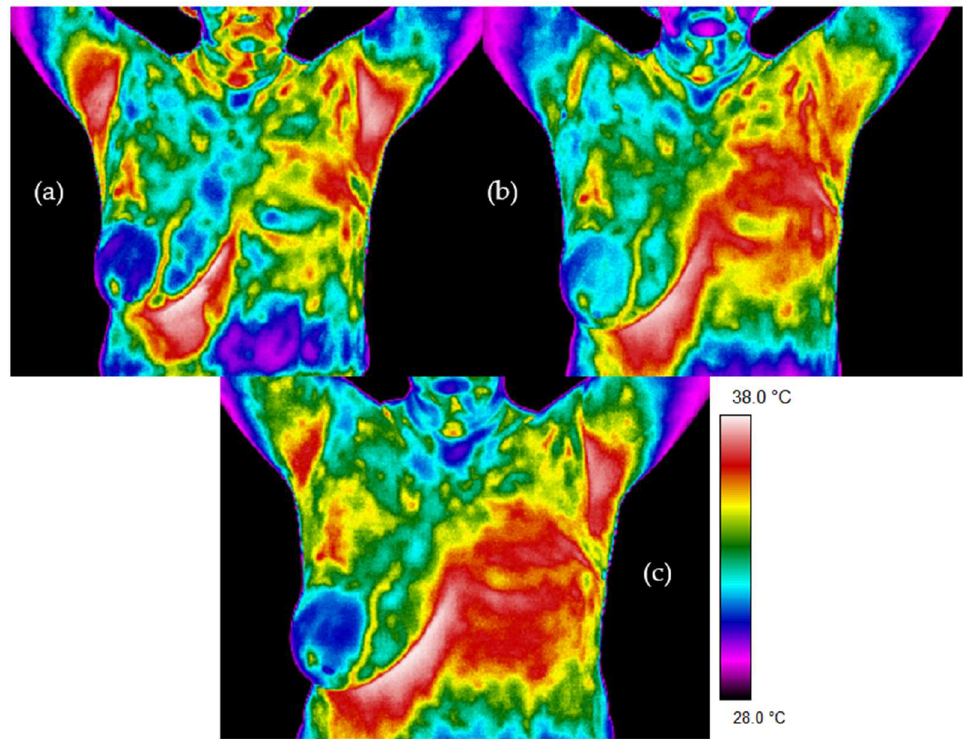
Figure 2. Examples of thermograms for patient 1: ( a ) before radiotherapy, ( b ) 2 months after radiotherapy and ( c ) 6 months after radiotherapy.